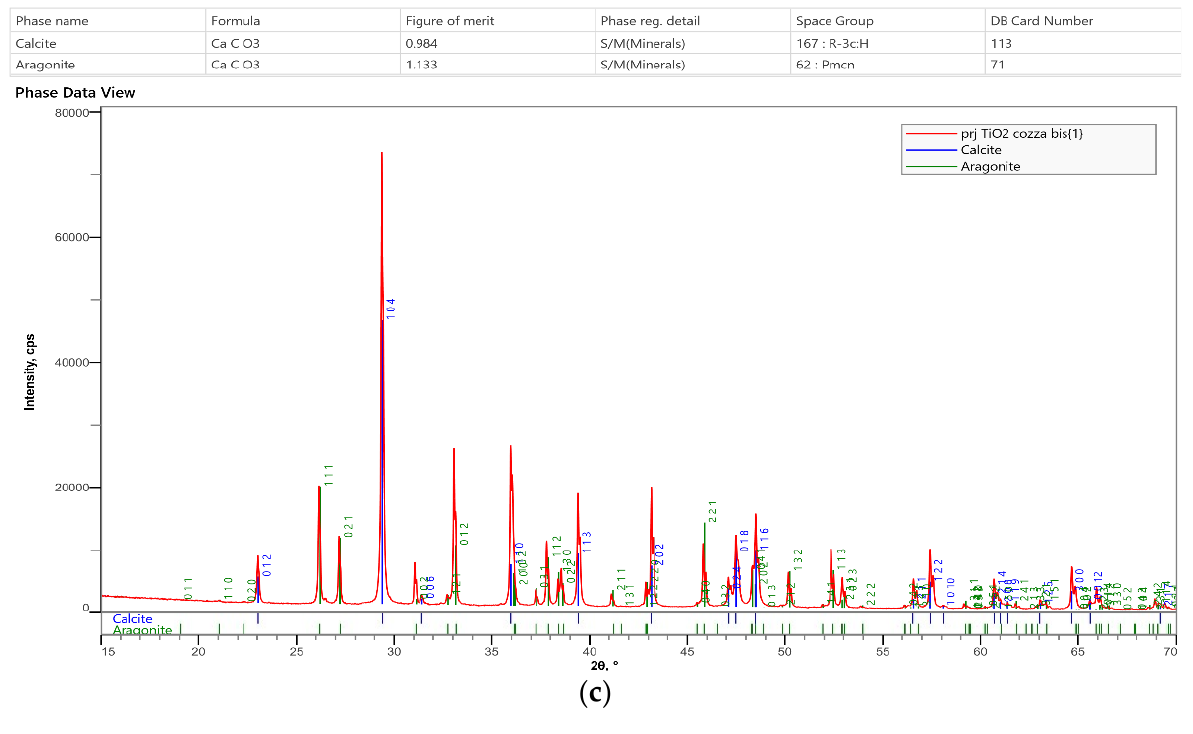
Figure 3. The first figure is the detection area of tested shell. ( a ) Energy Dispersion Spectra showing the relative abundance of the elements composing the matrix as function of the peak’s intensity. ( b ) XRD diffractogram of the nanoparticles previously identified using microanalysis (TiO 2 ). ( c ) XRD diffractogram of mussel shells. The phases composition is consistent with calcite-aragonite and there is no evidence of TiO 2 .